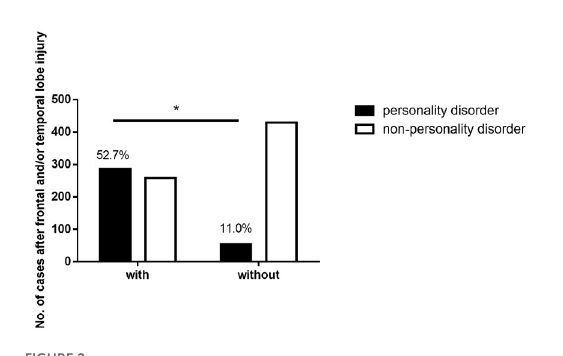
FIGURE2 The incidence rate of personality disorders after frontal and/or temporal lobe injury. * The difference was statistically significant between two groups. The incidence rate of personality disorder after frontal and/or temporal lobe injury was 52.7% (287 in 545 cases). The incidence rate of personality disorder after neither frontal lobe nor temporal lobe damage was 11.0% (53 in 482 cases), which was significantly lower than the incidence rate after frontal and/or temporal lobe injury ( χ 2 = 200.5, P <